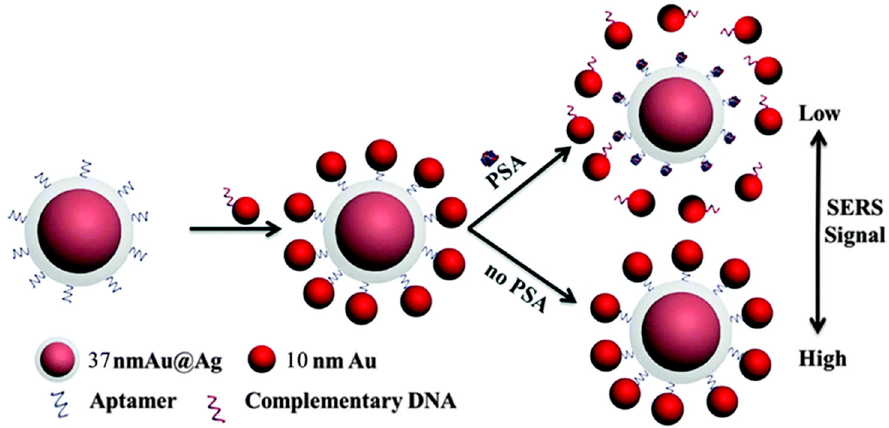
Figure 3. Schematic of a method for prostate-specific antigen (PSA) detection based on aptamer-directed core–satellite assemblies. (Reproduced with permission from [67]. Copyright 2014, RSC.)